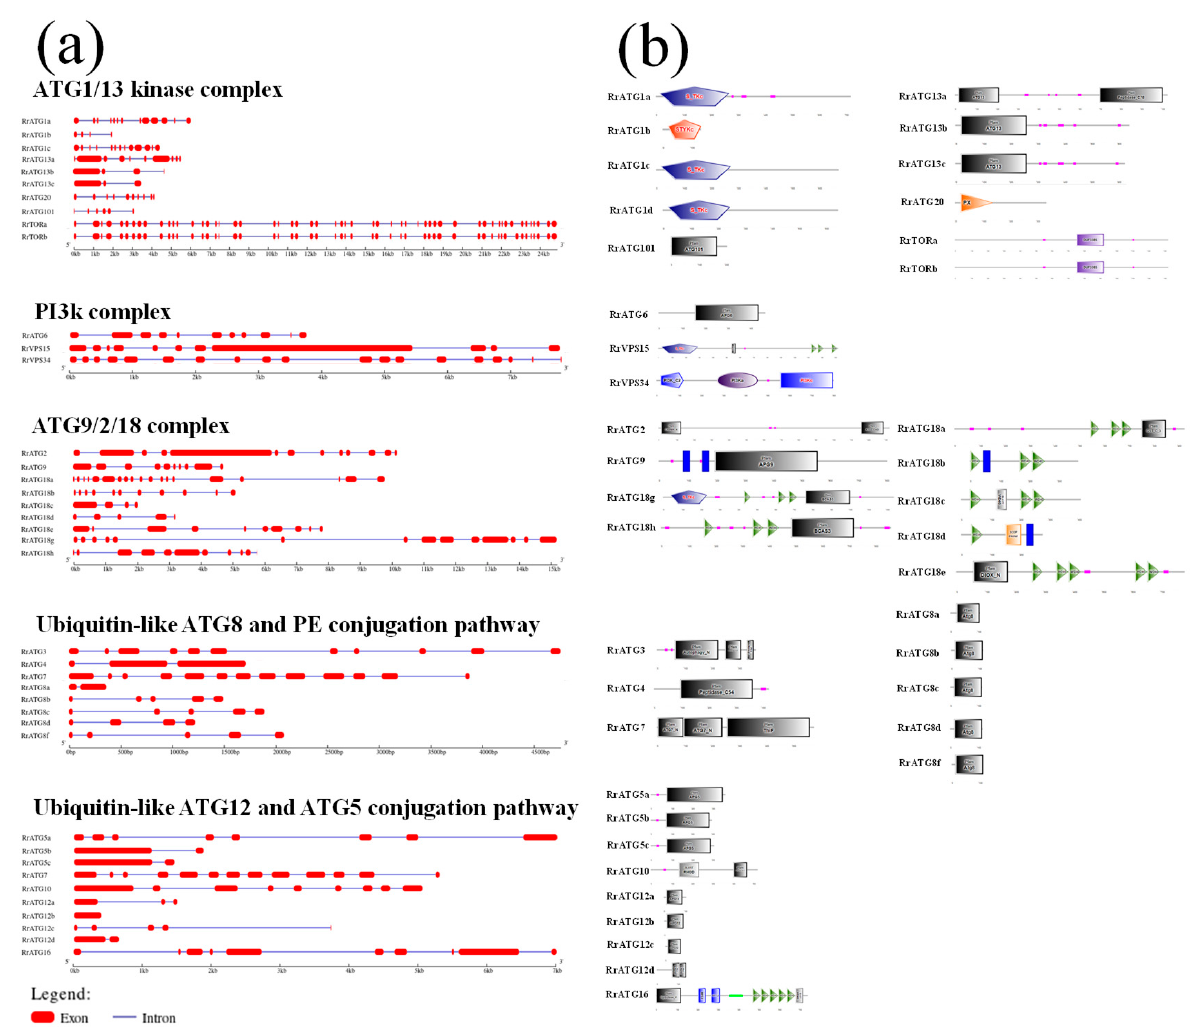
Figure 3. Gene structures and conserved domains of RrATGs. ( a ) Exon–intron of RrATGs , exons indicated by red squares and introns indicated by blue lines. ( b ) The predicted proteins conserved domain of RrATGs.